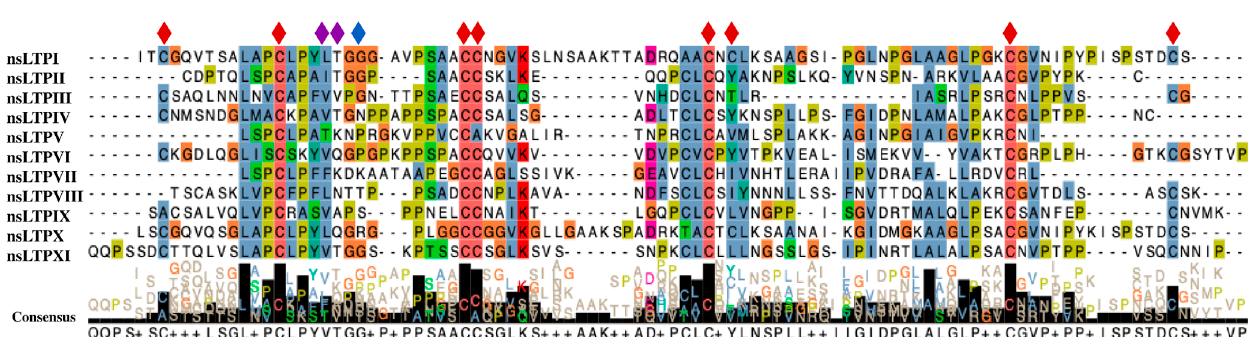
Figure 1. Alignment of representative sequences of each nsLTP type. Diamonds (above) indicate regions of conserved amino acid residues, red for 8M motif cysteines, blue for glycine and purple for residues contributing to helix spacing. The Clustal X colour scheme highlights conserved amino acid residues besides their physicochemical characteristics. The black bar below refers to the conservation between all aligned sequences with their respective amino acids. The consensus sequence is presented at the bottom of the figure, where the “+” signs indicate high variable positions.